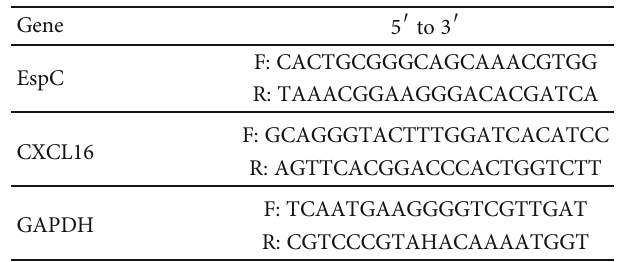
Figure 1: Vaccination of mice with BCG induced the production and expression of IFN- γ by T cells in the lavage fl uids, nasal mucosa, trachea, and lungs. (a) Scheme of immunization. (b) Respiratory system tissues of lavage fl uids nasal mucosa, trachea, lung, and blood cells were stimulated for 48hrs with or without BCG plus anti-CD28 in the plate. The culture supernatants were detected for the production of INF- γ by ELISA. (c) The levels of IFN- γ in plasma, BALF, and NLF were detected by ELISA as mean ± SEM . Statistical signi fi cance was determined with two-way ANOVA. ∗∗ P < 0 : 01 and ∗∗∗ P < 0 : 001 ; ns: no signi fi cance. Table 2: Sequence of primers used for Table 1: The antibodies used in fl ow cytometry.